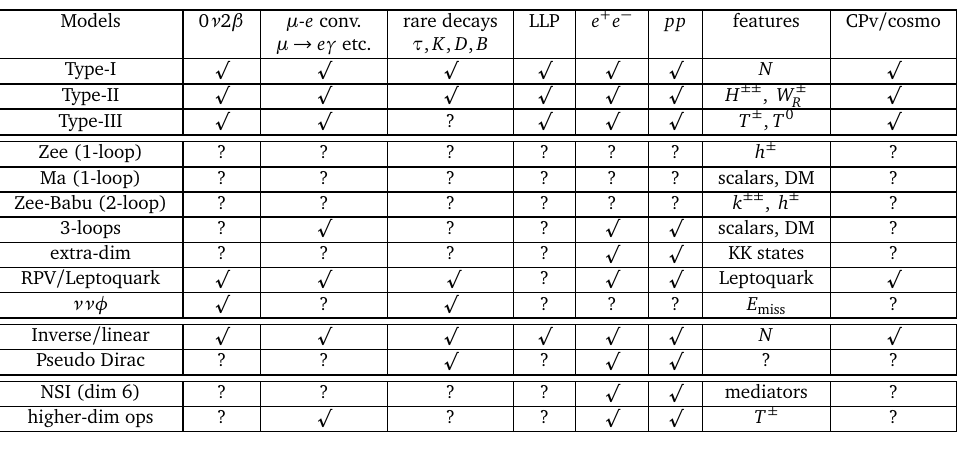
Table 3.1: Summary of neutrino mass models and testable features. studied and ? means more work